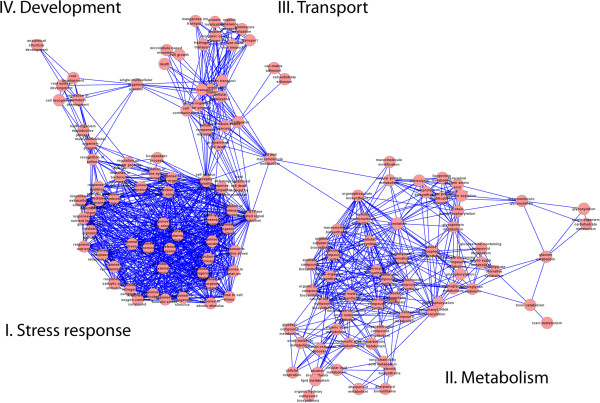
ReviGO analysis of enriched GO terms. Significantly enriched GO terms were clustered by semantic similarities and four overall clusters pointed out.